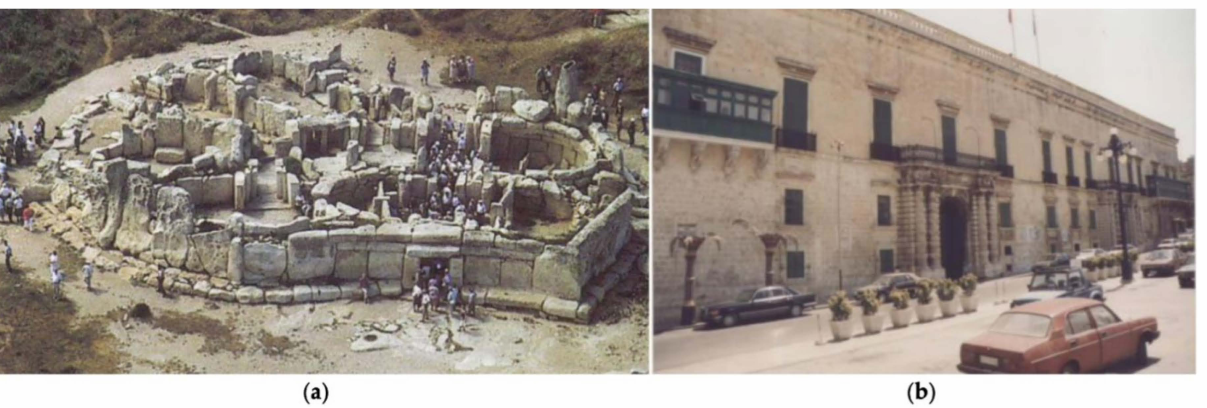
the location of case-studies is also included (© Google